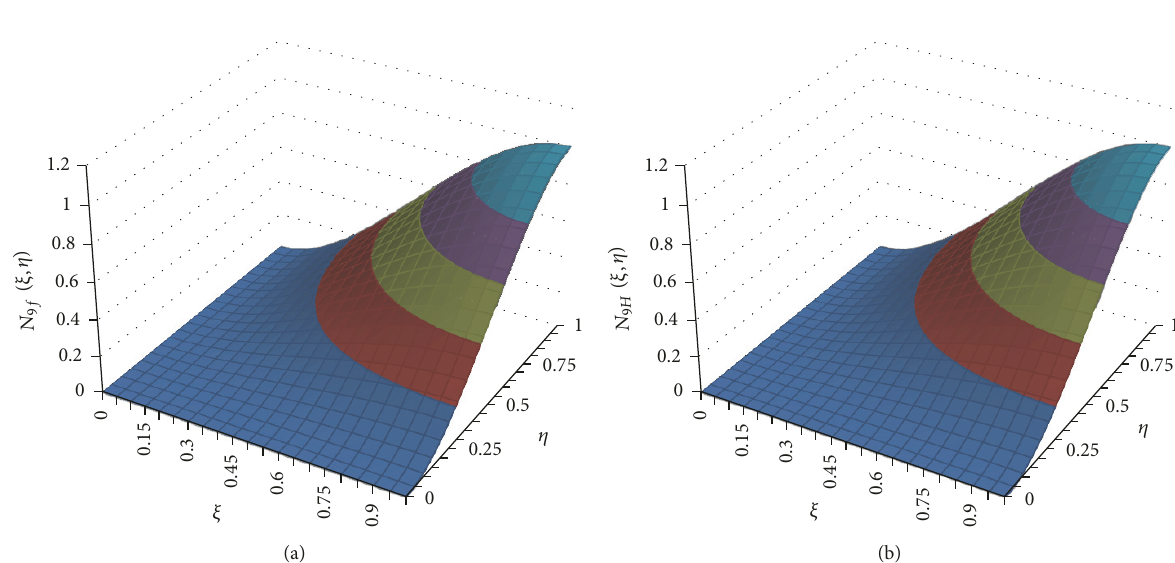
Figure 7: DFE (a) and FEM (b) shape function for 𝑤 3 at node